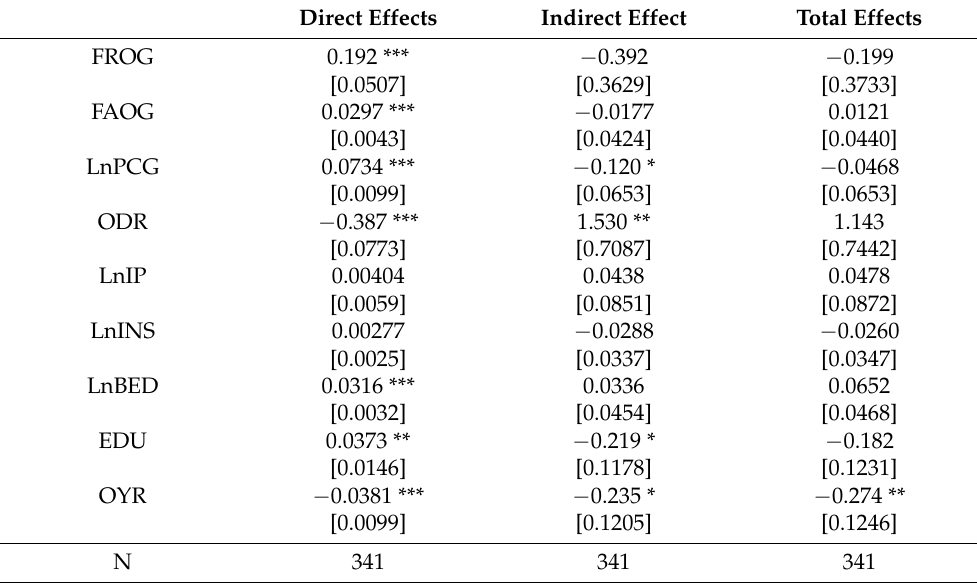
Table 10. Estimation results of spatial effect